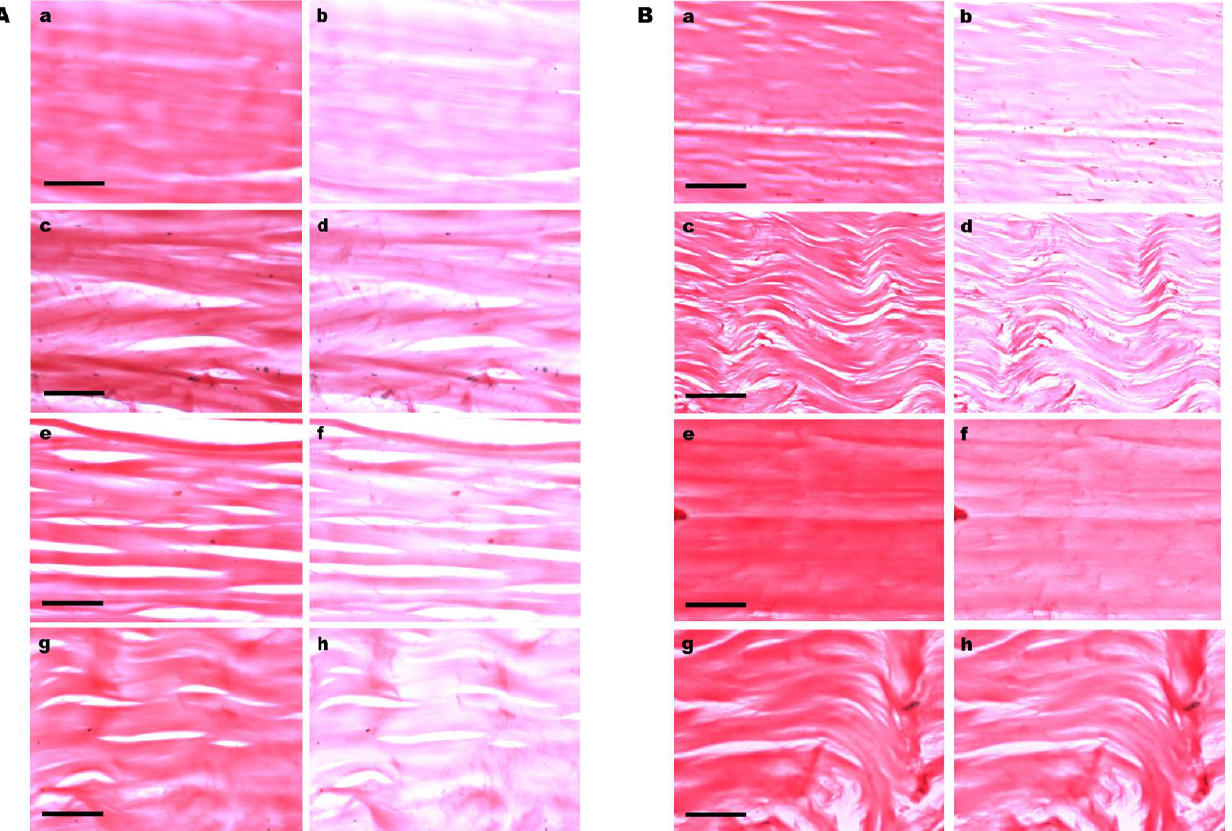
Figure 2. Positive LD in Ponceau SS-stained tendon collagen bundles. ( A ) Images representative of stained collagen bundles in control tendons ( a , b ) and tendons cultivated on glass coverslips ( c – h ). The long axes of the tendons were positioned parallel ( a , c , e , g ) and perpendicular ( b , d , f , h ) to the PPL. Images ( g , h ) correspond to the extremity tendon zone distal to the region originally occupied by the enthesis in vivo. ( B ) Images representative of stained collagen bundles in tendons cultivated on plastic dishes ( a – h ). The long axes of the tendons were positioned parallel ( a , c , e , g ) and perpendicular ( b , d , f , h ) to the PPL. Images ( c , d , g , h ) were obtained at zones distal to the region originally occupied by the enthesis. A less intense LD phenomenon was observed in tendons cultivated for 12 days, especially at zones distal to the region originally occupied by the enthesis ( g , h ). Scale bars equal 50 µm ( A ( a – h )) and ( B ( e – h )) and 100 µm ( B ( a – d )).